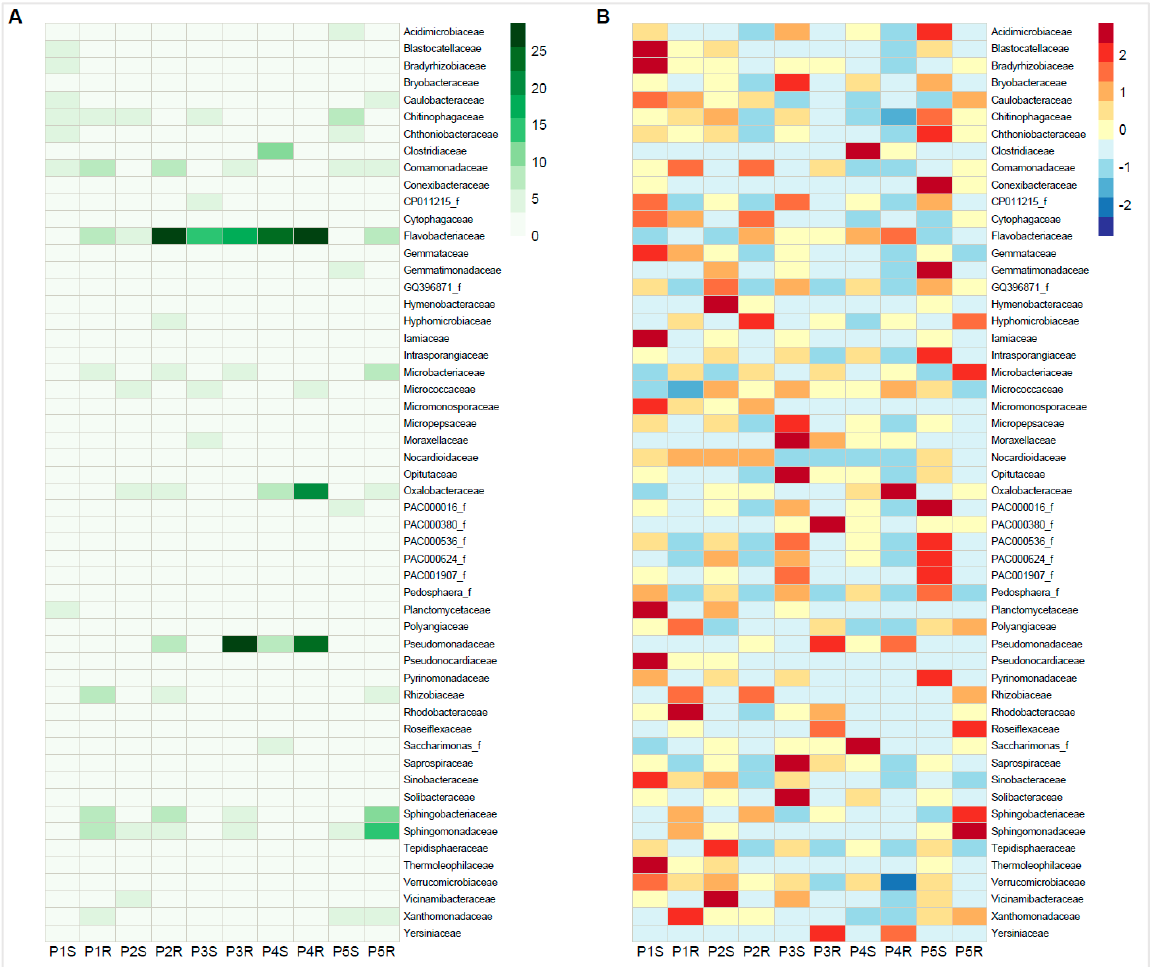
Figure 3. Relative abundance heatmap of sequences identified on a family-rank taxonomic level. ( A )—Relative abundance according to sequence percentage value; color scale—relative abundance (%), ( B )—Scaling within family rows across all examined samples; relative abundance above average—red, relative abundance below average—blue. S—rhizospheric soil samples, R—root samples, P1–P2—Central European (Poland) samples, P3–P5—Antarctic samples (King George Island).